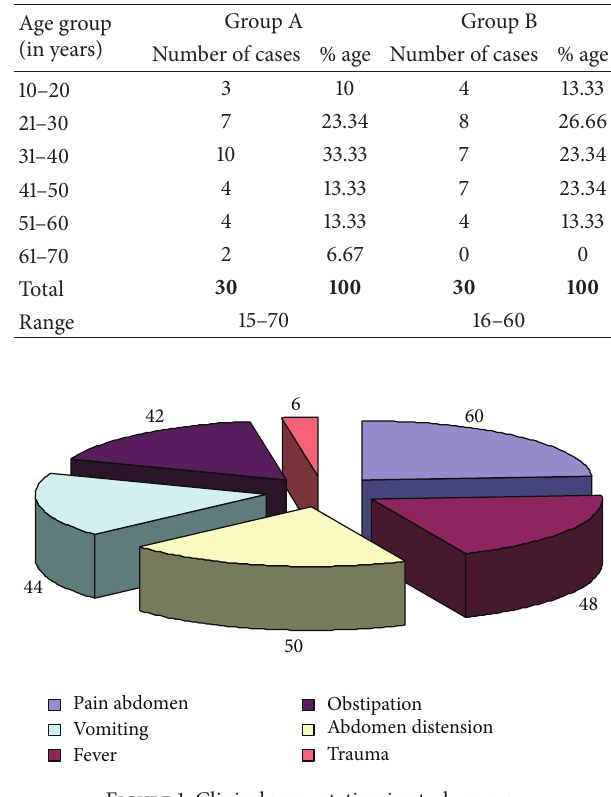
Figure 1: Clinical presentation in study